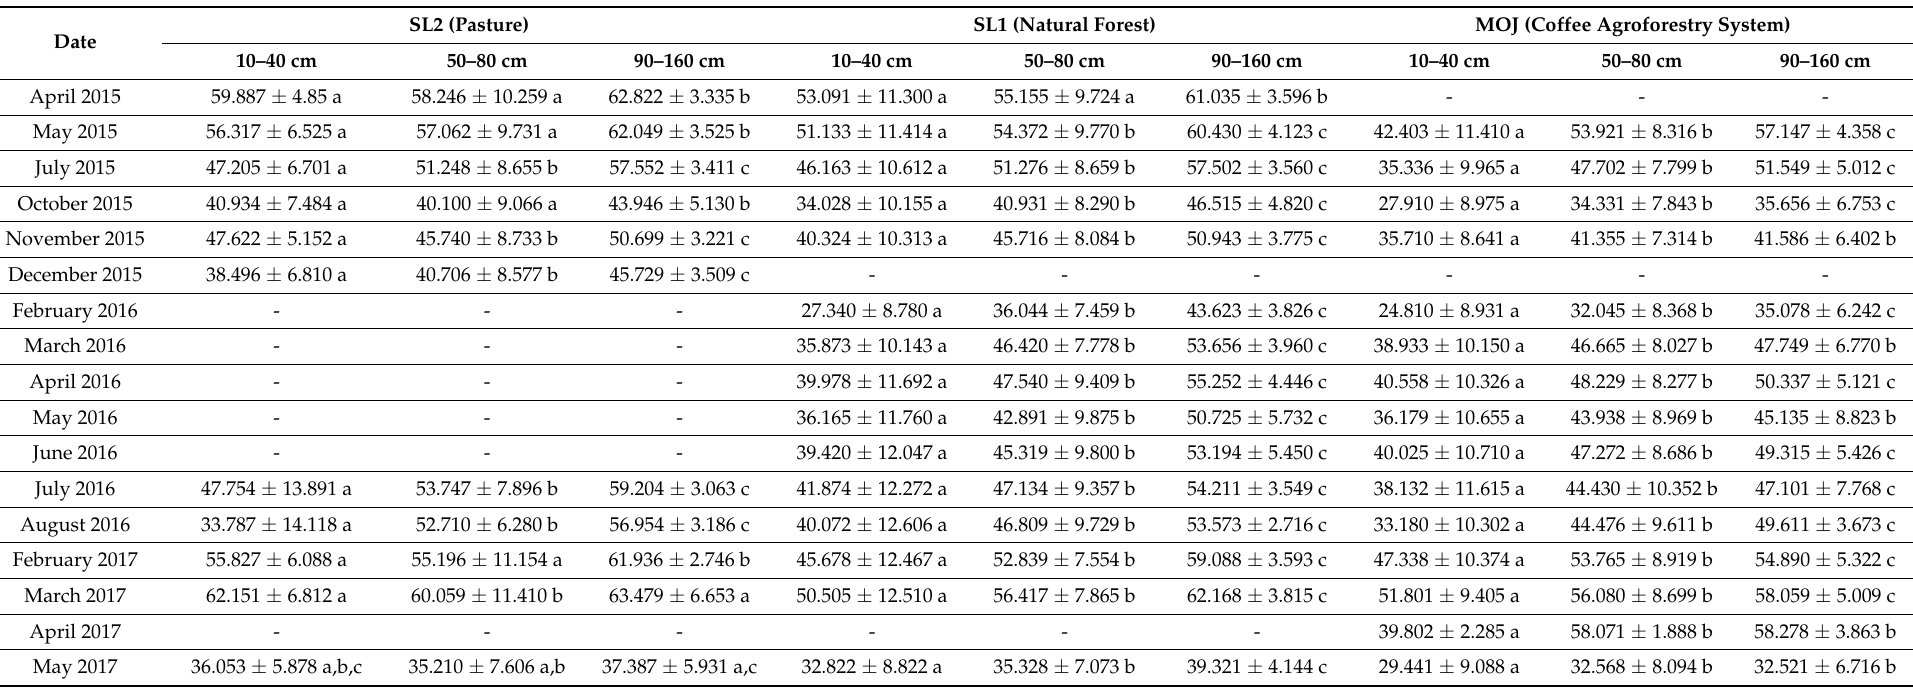
Table 5. Test Tukey ( p < 0.05) for the mean volumetric soil moisture by depth ranges and soil uses in the microbasins of Cali River